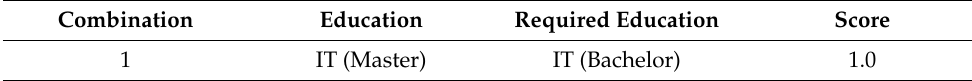
Figure 10. CQ_03: Which job posts match the migrant’s education? Table 5. Education